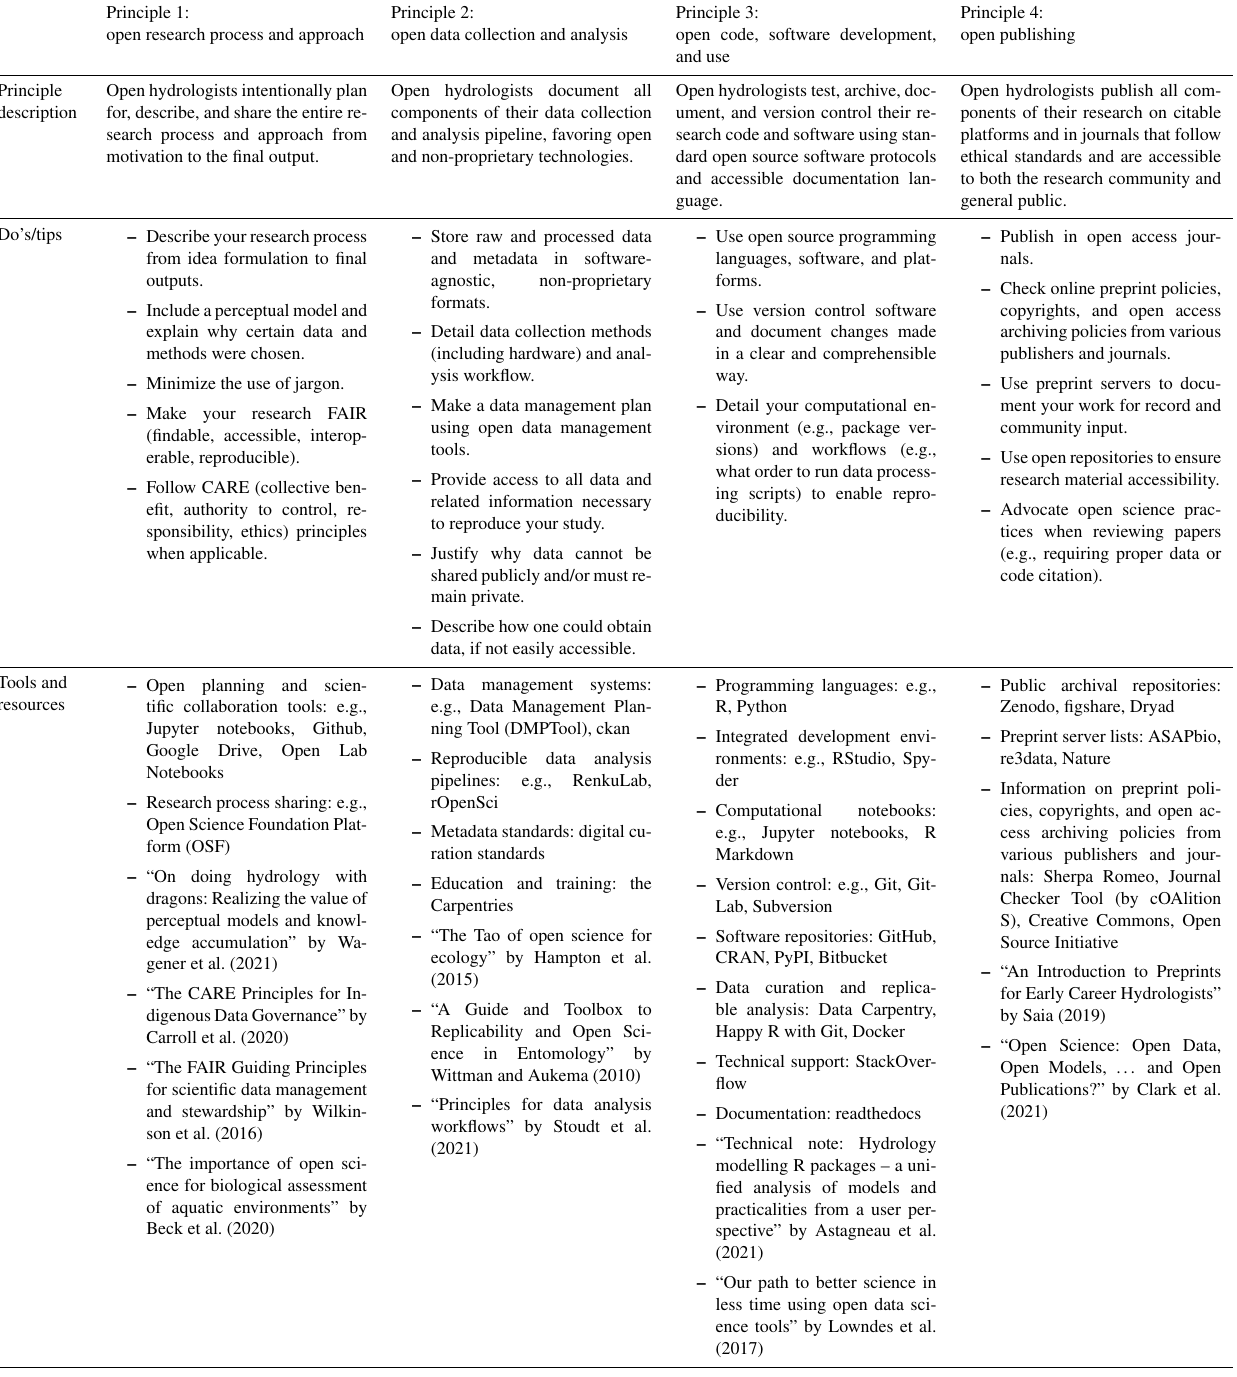
Table 2. Summary of tips, tools, and resources for the Open Hydrology Principles and Practical